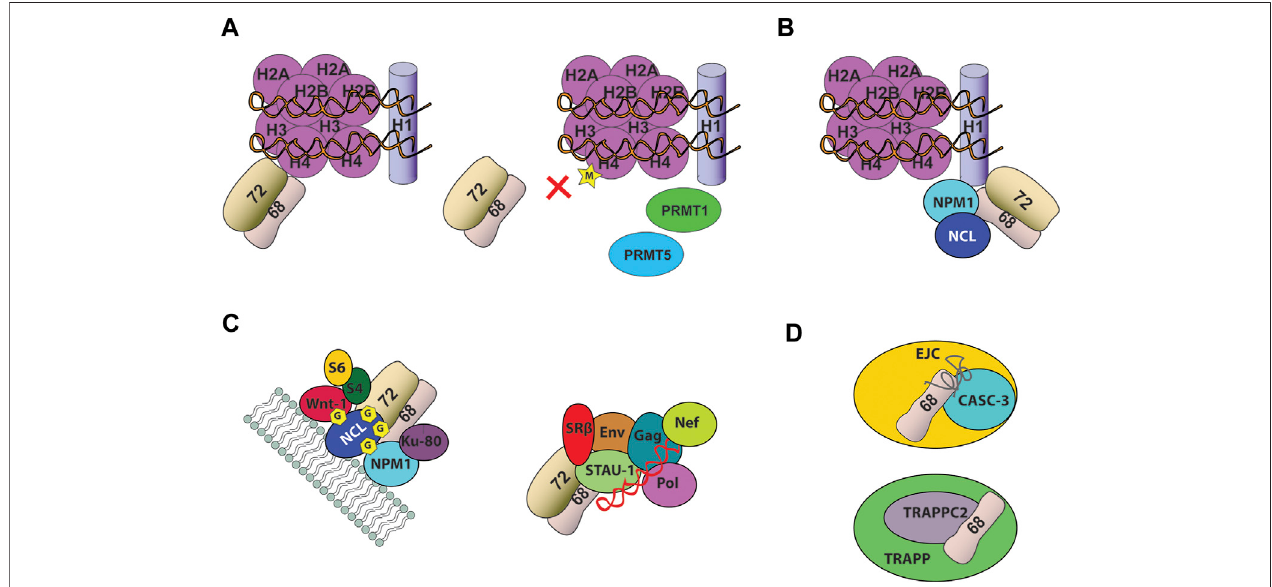
FIGURE4| NoncanonicalfunctionoftheheterodimerSRP68/72 (A) SRP68/72bindsthetailofH4.DimethylationofH4byPRMT1andPRMT5causesSRP68/72 chromatin dissociation and shuttle in the cytoplasm (B) SRP68/72 binds C-terminal domain of H1 linker histone (C) SRP68/72 heterodimer was identi fi ed in different RNPs.Itwasfoundassociatedwithcell-surfacenucleolin(NCL)inahighlystable500-kDaproteincomplexincludingseveralproteins(left)andinStaufen1-RNPcomplex (right), including four viralproteins(Gag, Env,Pol,Nef), theviral RNA(shown inred)and more than 200other proteins (D) SRP68wasfoundassociatedtoCASC-3 and TRAPPC2, respectively in EJC and TRAPP particles. Depicture of interactions in complexes are schematic